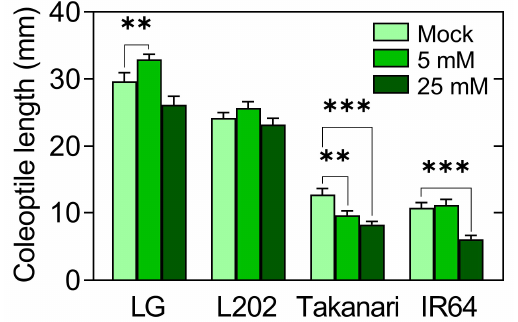
Figure 5. The influence of exogenous glucose on coleoptile elongation under oxygen deprivation in rice varieties with and without anaerobic germination tolerance. Seeds were incubated under 12 h light and 12 h dark cycles for 5 days in deoxygenated water containing 0 mM (mock), 5 mM, and 25 mM glucose. Data represent means ± SE ( n = 20). Asterisks indicate a significant difference between mock and glucose-treated samples (** p < 0.01, *** p < 0.001; t -test).